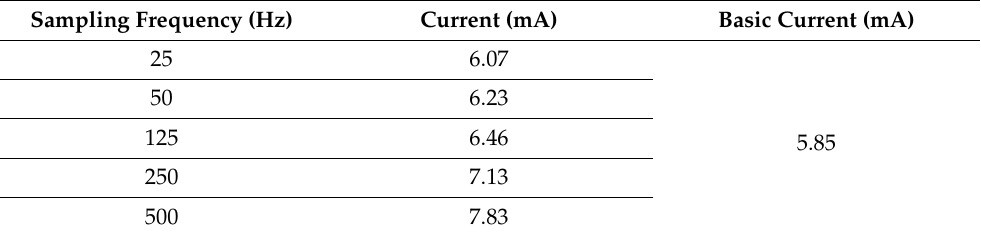
Table 5. The current measurement of the proposed method.